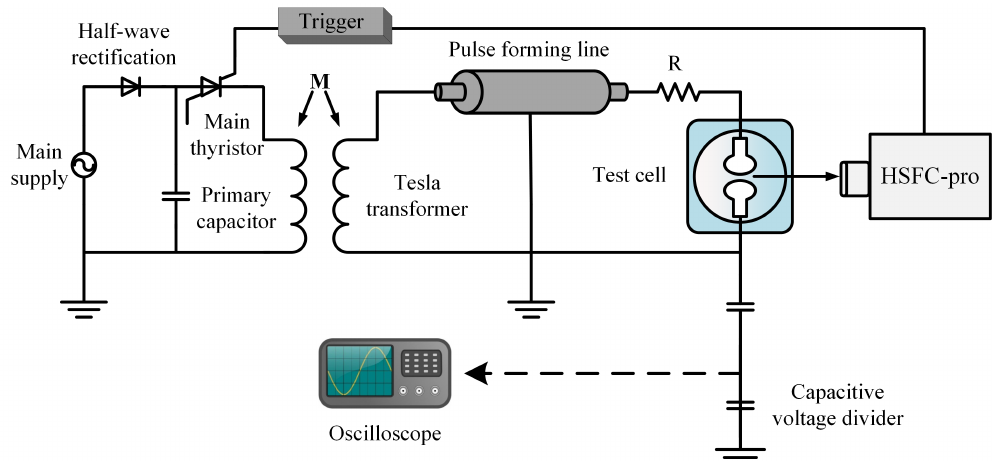
Figure 2. Schematic diagram of the microsecond pulse breakdown strength test platform.